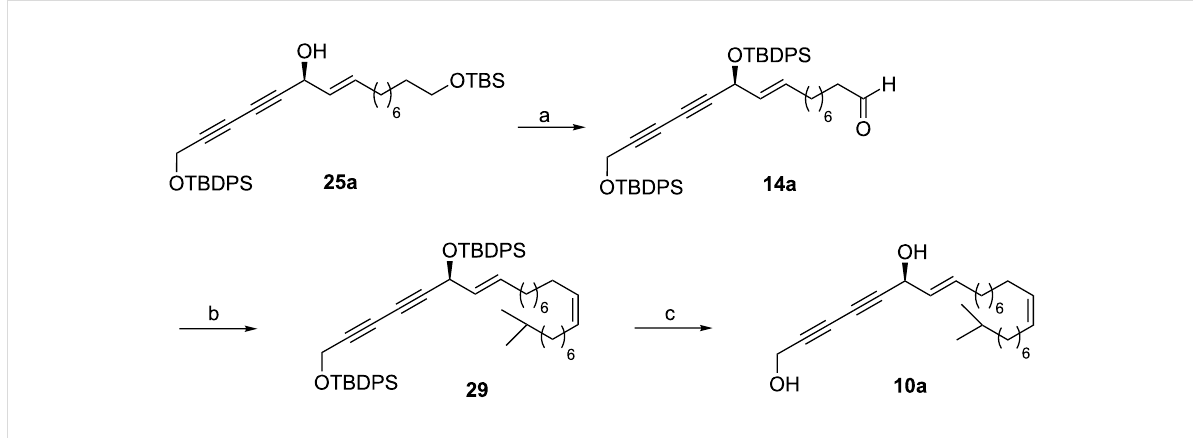
Scheme 6: Synthesis of strongylodiol I ( 10a ). Reagents and conditions: (a) (i) TBDPSCl, imidazole, CH 2 Cl 2 , 0 °C to rt, 1 h, 96%; (ii) PPTS, MeOH, 0 °C to rt, 2 h, 87%; (iii) IBX, DMSO/THF 1:1, 0 °C to rt, 1 h, 98%; (b) 16 , n -BuLi, THF, − 78 °C to rt, 2 h, 81%; (c) TBAF, THF, 0 °C to rt, 2 h, 82%.